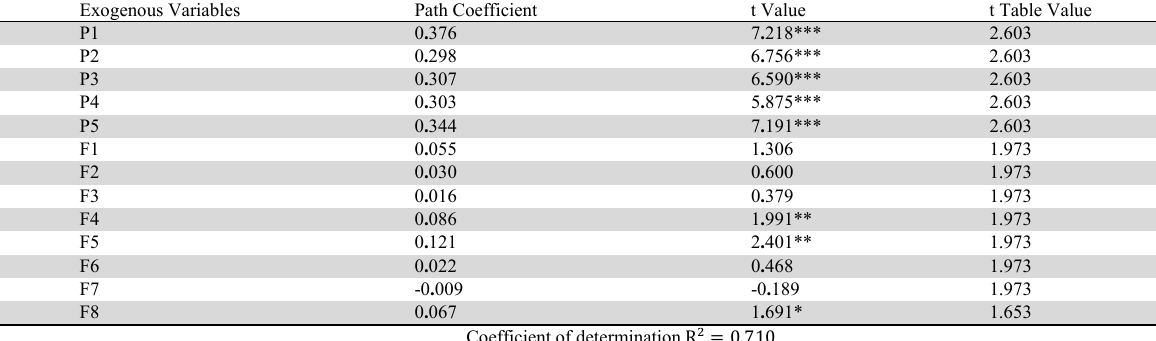
Path Coefficient and Significance of Exogenous